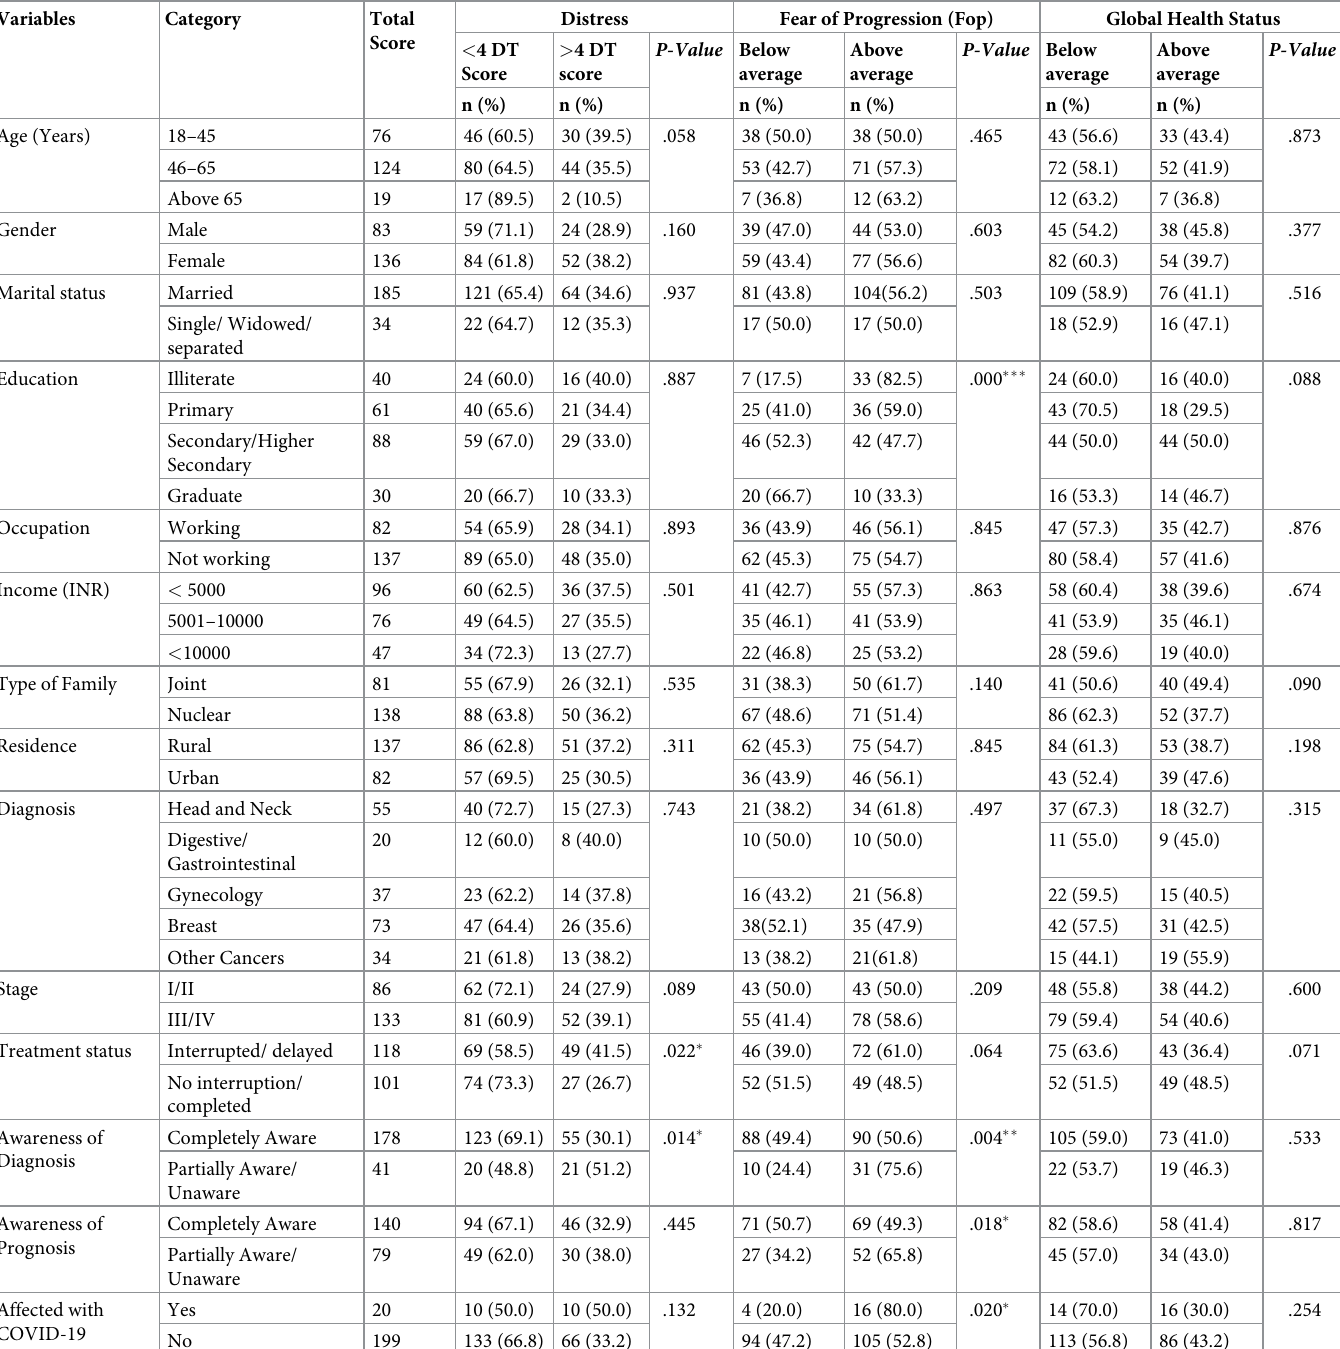
Table 2. Association of personal and clinical characteristics with distress, FOP and global health status during COVID-19